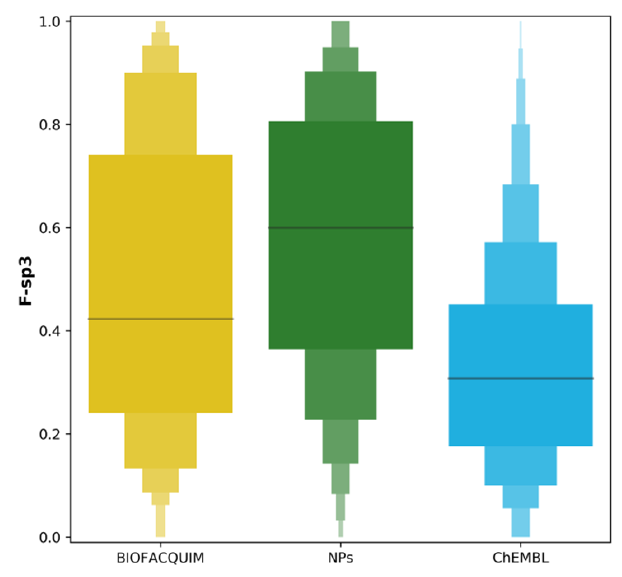
Figure 3. Distribution of F-sp3 for BIOFACQUIM, NPs, and